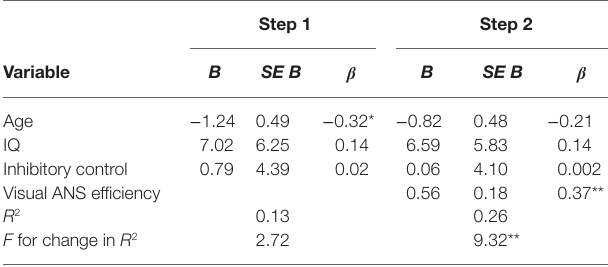
TABLE 1 | Summary of hierarchical linear regression analysis for variables predicting auditory ANS efficiency prior to